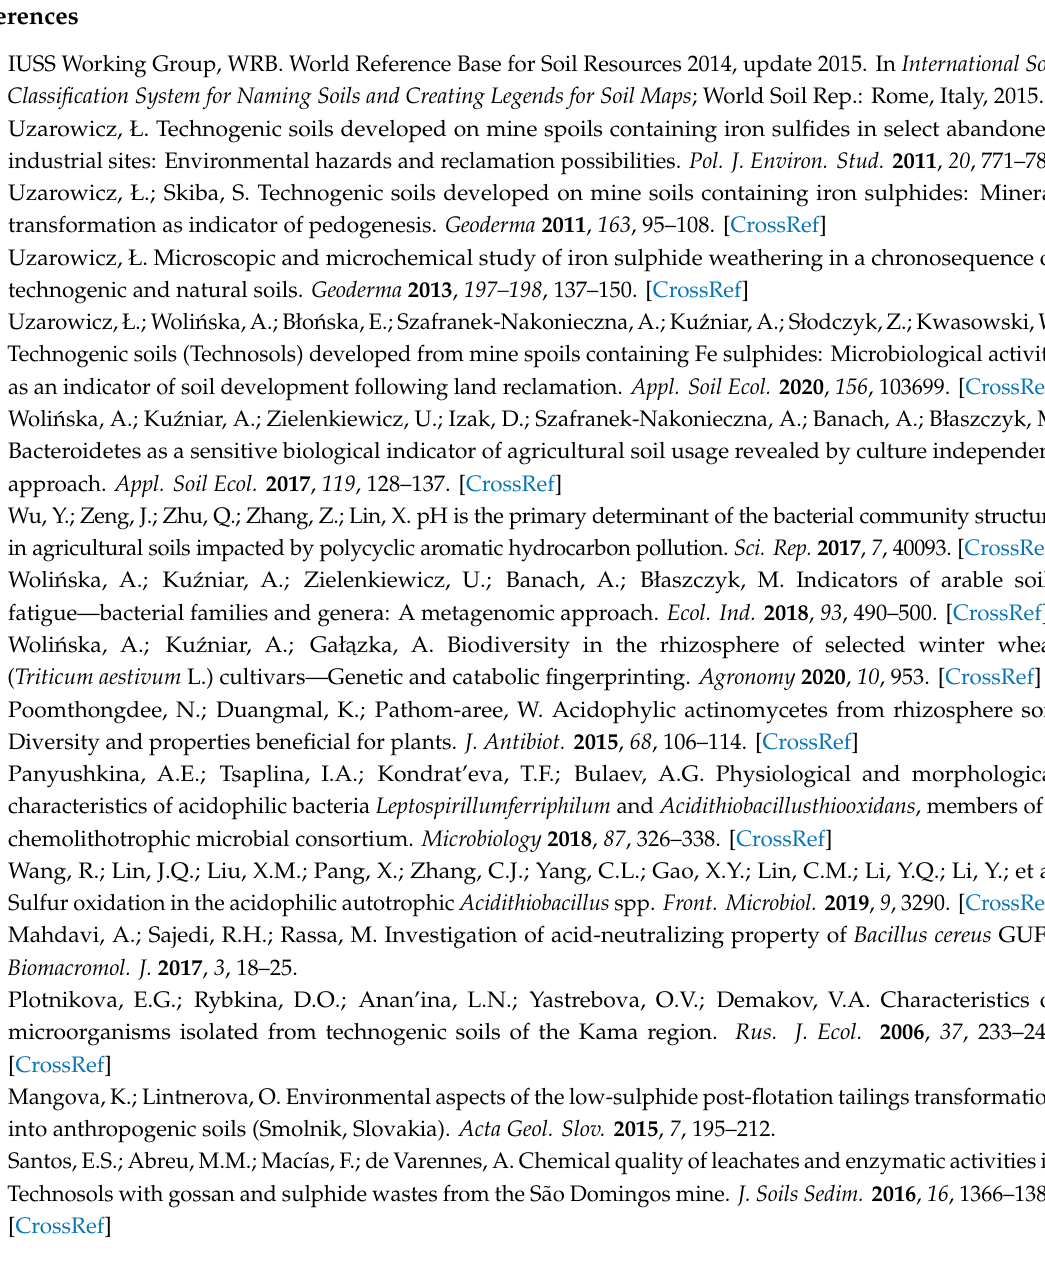
the studied soil profiles. Figure S3: Utilization of all substrates in the studied samples based on the analysis with the use of Biolog ® EcoPlates ™ . Table S1: Selected properties of studied Technosols. Table S2: Sequencing data quality. Table S3: